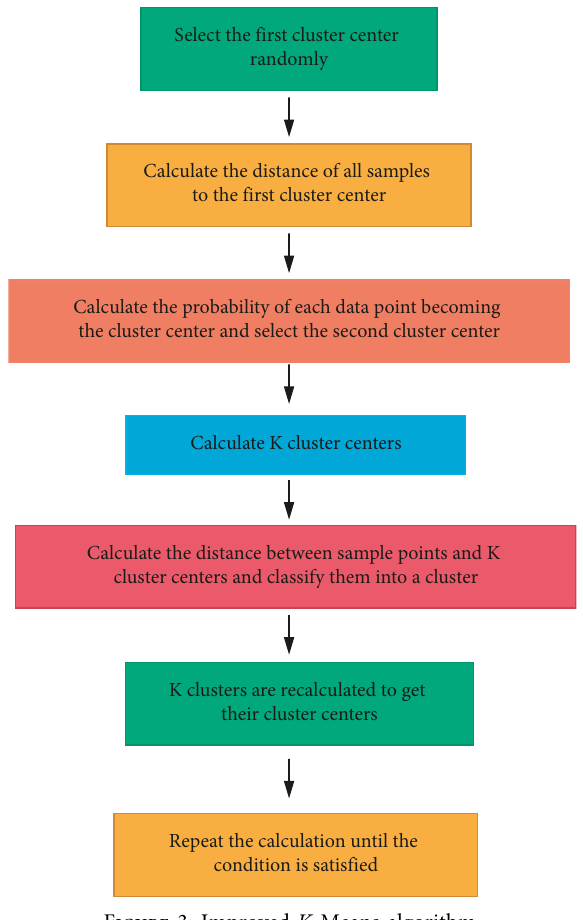
Figure 3: Improved K -Means